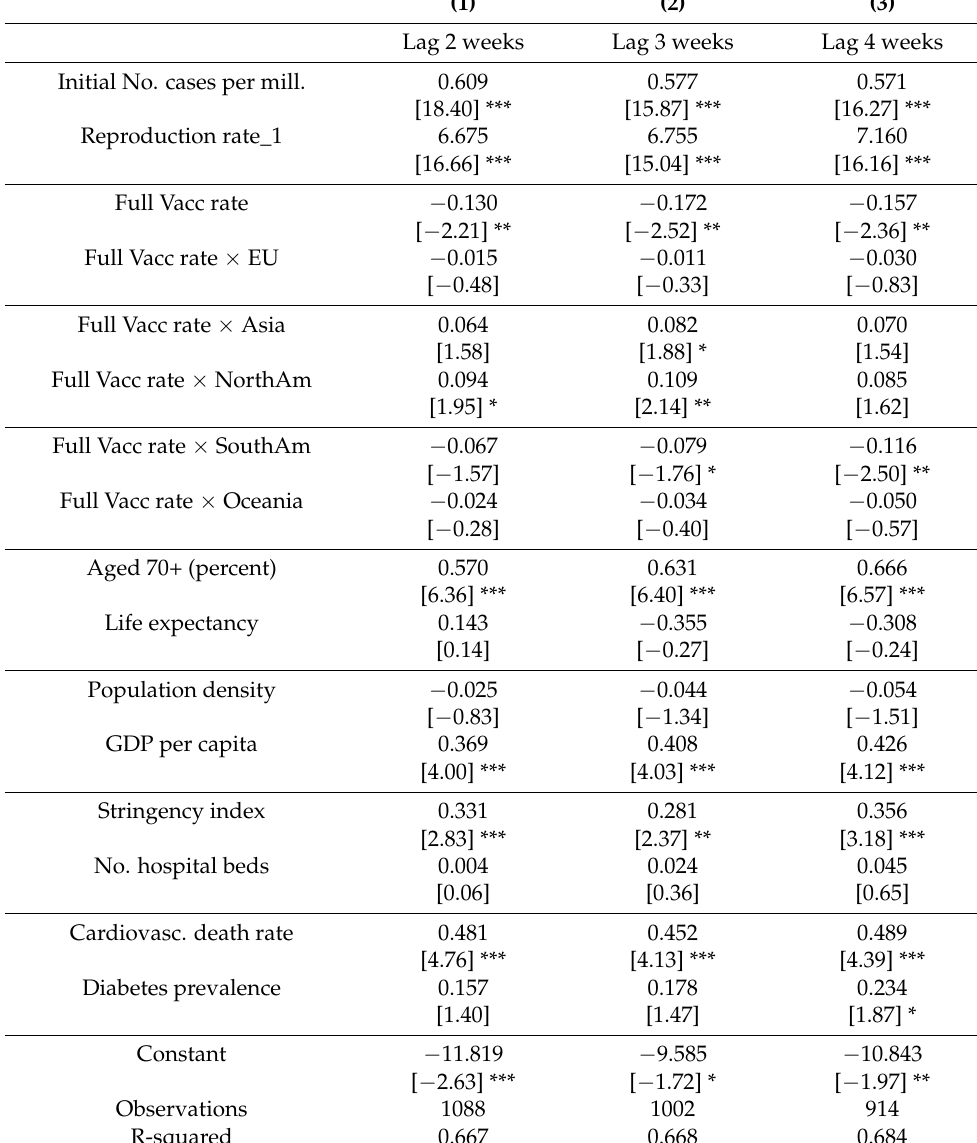
Table 1. Impact of vaccination rate on number of new COVID